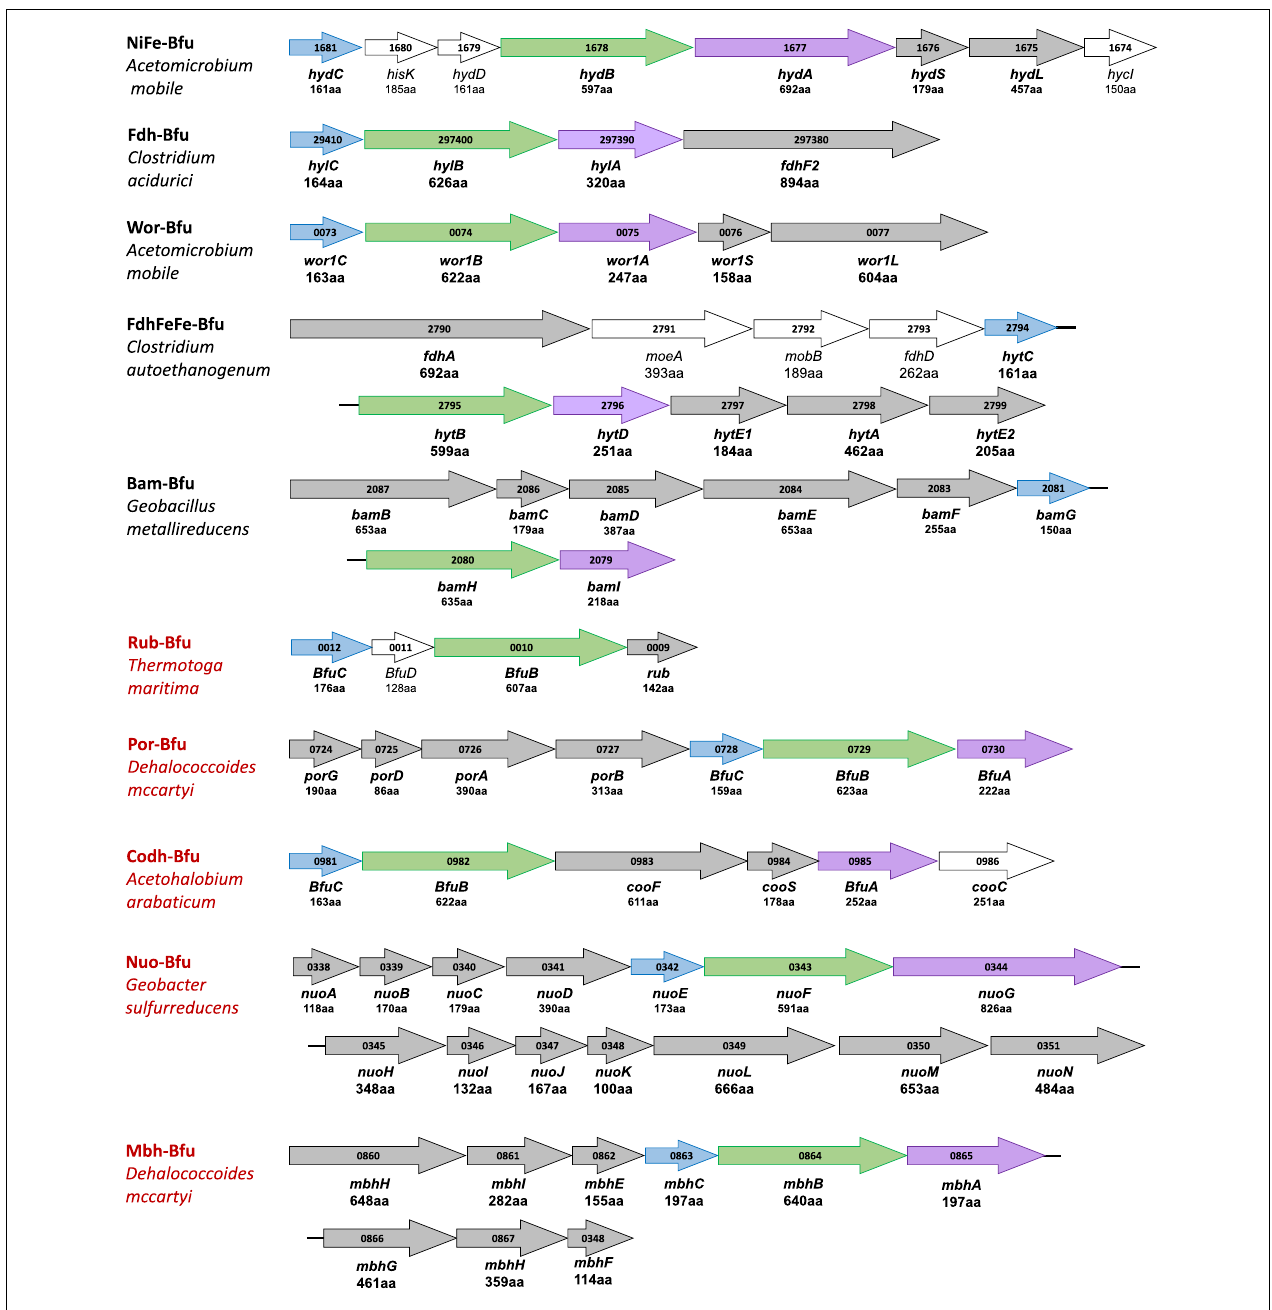
FIGURE 3 | Gene cluster organization of characterized and predicted electron bifurcating complexes with homologous Bfu(Hyd)ABC domains. Characterized and predicted enzymes and their microbial sources are shown in black and red font, respectively. Homologous Bfu subunits are colored purple (BfuA), green (BfuB), and blue (BfuC) where the colors correspond to those used in Figures 1 , 6 – 9 and Supplementary Figures 1A–F . Additional subunits of the Bfu enzyme are shown in gray while genes encoding processing or regulatory proteins are designated by plain text and are not colored. Numbers inside the arrows refer to the gene number. The numbers of amino acids that are encoded by each gene are listed under the gene name. Bold gene names are part of the holoenzyme.